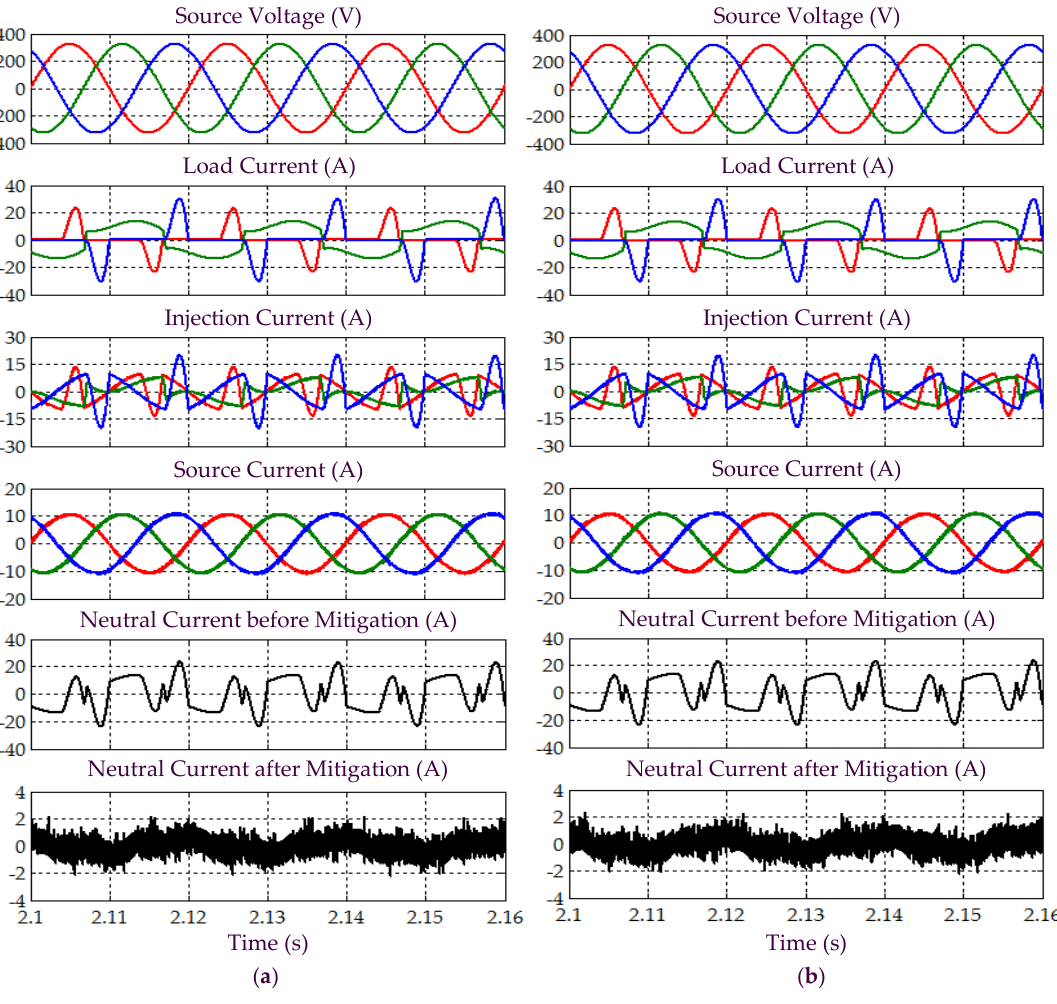
Figure 6. Simulation results obtained under Scenario A for Load 1, which include three-phase source voltage 𝑣 𝑆𝑎𝑏𝑐 , load current 𝑖 𝐿𝑎𝑏𝑐 , injection current 𝑖 𝑖𝑛𝑗𝑎𝑏𝑐 , source current 𝑖 𝑆𝑎𝑏𝑐 , and neutral current before and after mitigation, demonstrated by SAPF while applying the ( a ) proposed STF- dq 0 and ( b ) standard dq 0 techniques.